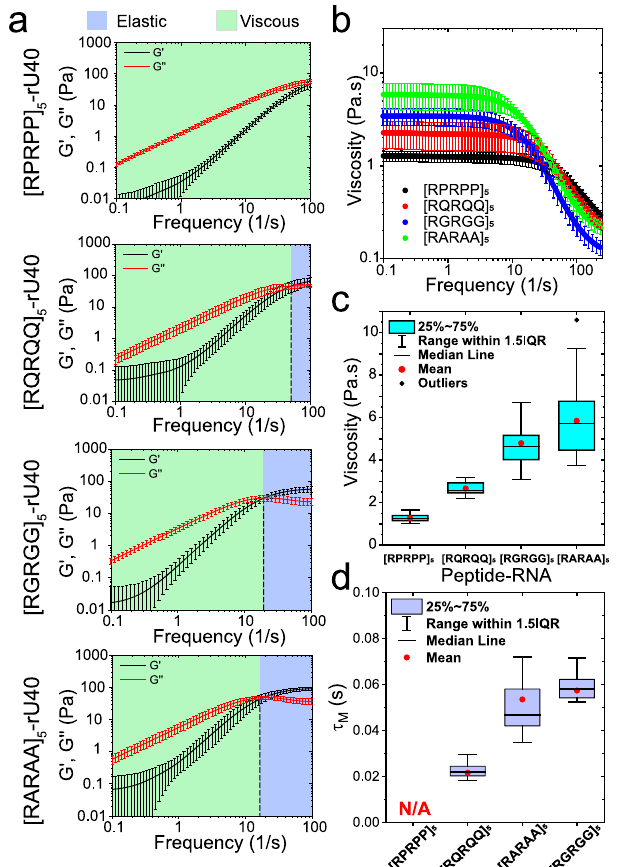
Fig. 3 Effect of spacer sequence variation on the frequency-dependent viscoelasticity of peptide-RNA condensates. a Average viscoelastic moduli of [RxRxx] 5 -rU40 condensates. The crossover frequencies are indicated by black dashed lines. Shaded regions represent the dominant elastic regime (light-blue) and the dominant viscous regime (light-green), respectively. Error bars represent one standard deviation (±1 s.d.). b The frequency-dependent viscosity of [RxRxx] 5 -rU40 condensates as measured by pMOT. Error bars represent one standard deviation (±1 s.d.). c The zero- shear viscosity of [RxRxx] 5 -rU40 condensates as measured by pMOT. d The terminal relaxation time τ M of [RxRxx] 5 -rU40 condensates as measured by pMOT. For the data shown in a – d : x = P/Q/G/A. For the data in a – d , the sample size is n = (18,14,18,17) measurements for x = (P,Q,A,G),